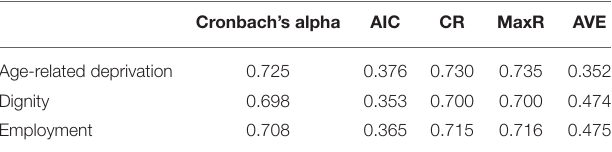
TABLE 3 | The results of the internal consistency, construct reliability, and convergent validity.